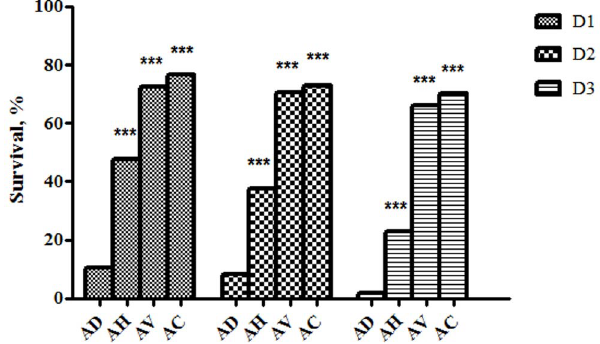
Figure 1. Three-day survivals of Caenorhabditis elegans co- cultivated with Aeromonas isolates of different species: Aero- monas dhakensis (AD), Aeromonas hydrophila (AH), Aeromonas veronii (AV), and Aeromonascaviae (AC) in the liquid-toxic assay. *** P , 0.0001, as compared with AD.